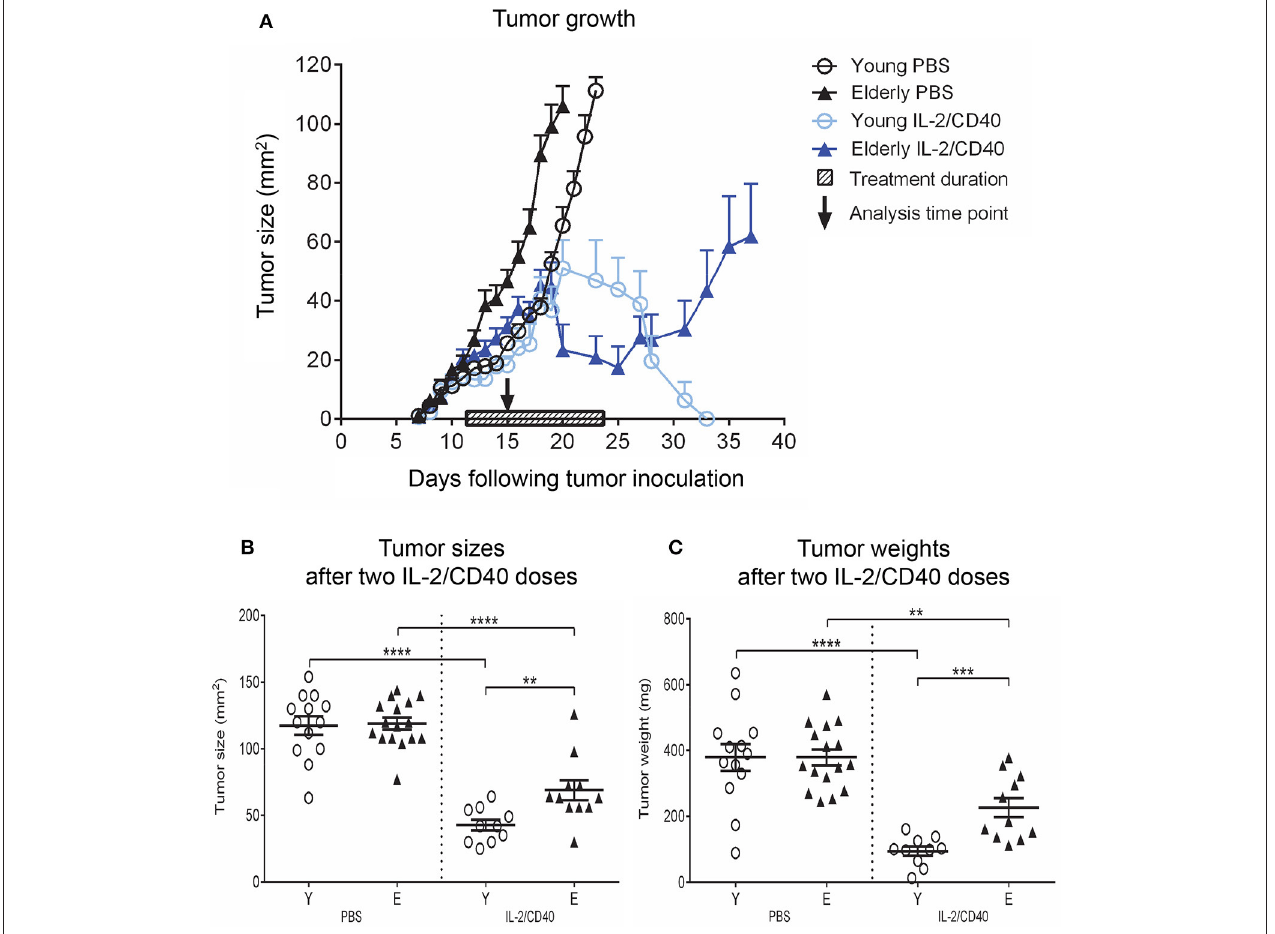
FIGURE 5 | IL-2/CD40 is less efficient at inducing tumor regression in elderly mice. Young ( n = 24) and elderly ( n = 27) mice were inoculated subcutaneously with 5 × 10 5 AE17 cells, and tumors left to develop before treatment with intra-tumoral IL-2 (20 µ g/dose) and agonist anti-CD40 antibody, 40 µ g/dose; n = 10 young and 11 elderly mice or PBS diluent ( n = 14 young and 16 elderly mice; 100 µ l/dose) for 5 doses, each 2–3 days apart. The shaded bar in (A) represents treatment duration. Tumor size (in mm 2 ) was measured to determine tumor growth rates and response to IL-2/CD40 (A) ; data shown as mean ± SEM. In a second experiment TDLNs and tumors were collected for analysis 2–3 days after the second dose, indicated by the black arrow in (A) , and tumor sizes (B) and tumor weights (C) in n = 10 young and 11 elderly mice given IL-2/CD40 and n = 14 young and 16 elderly mice given PBS measured; data are shown for individual mice as well as mean ± SEM, mouse numbers for C differed on account of varying cell numbers available for analysis and ranged from n = 10–13 young and n = 8–16 elderly PBS control mice, ** p < 0.005, *** p < 0.0005, **** p < 0.0001 comparing (i) young to elderly mice, or (ii) IL-2/CD40-treated mice to age-matched PBS control